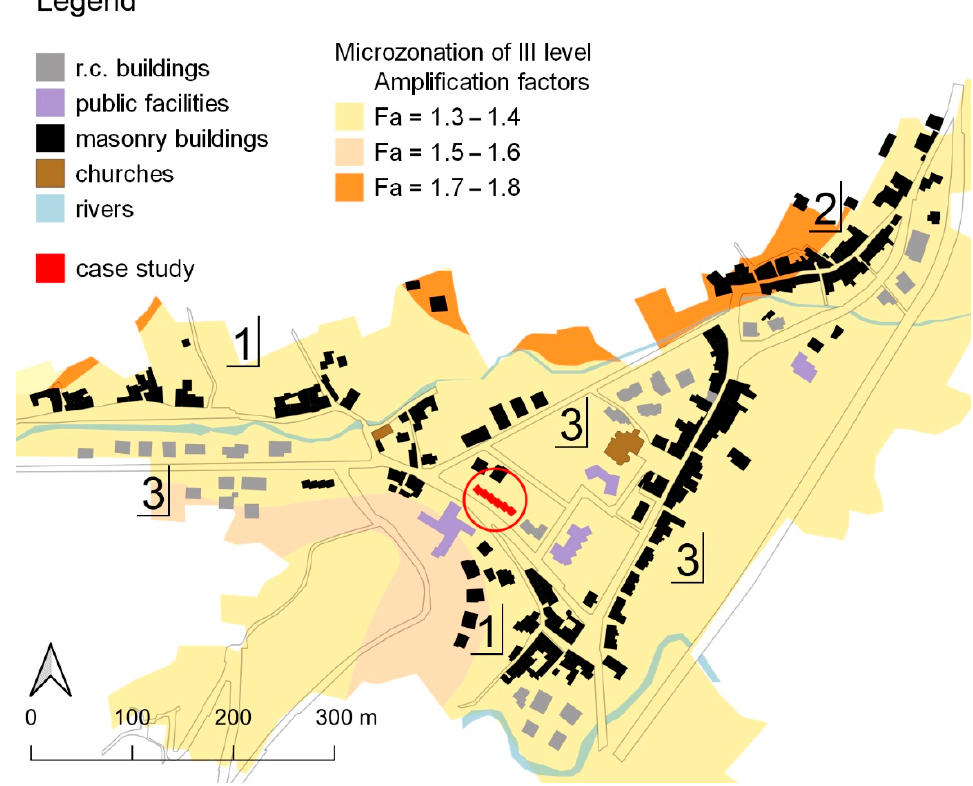
Figure 2. Pieve Torina: overview with village plan, soil amplification factors, structural and functional types of buildings, and location of case study. Key to numbers: (1) oldest nuclei; (2) 18th century building aggregates; (3) 20th century and recent buildings.